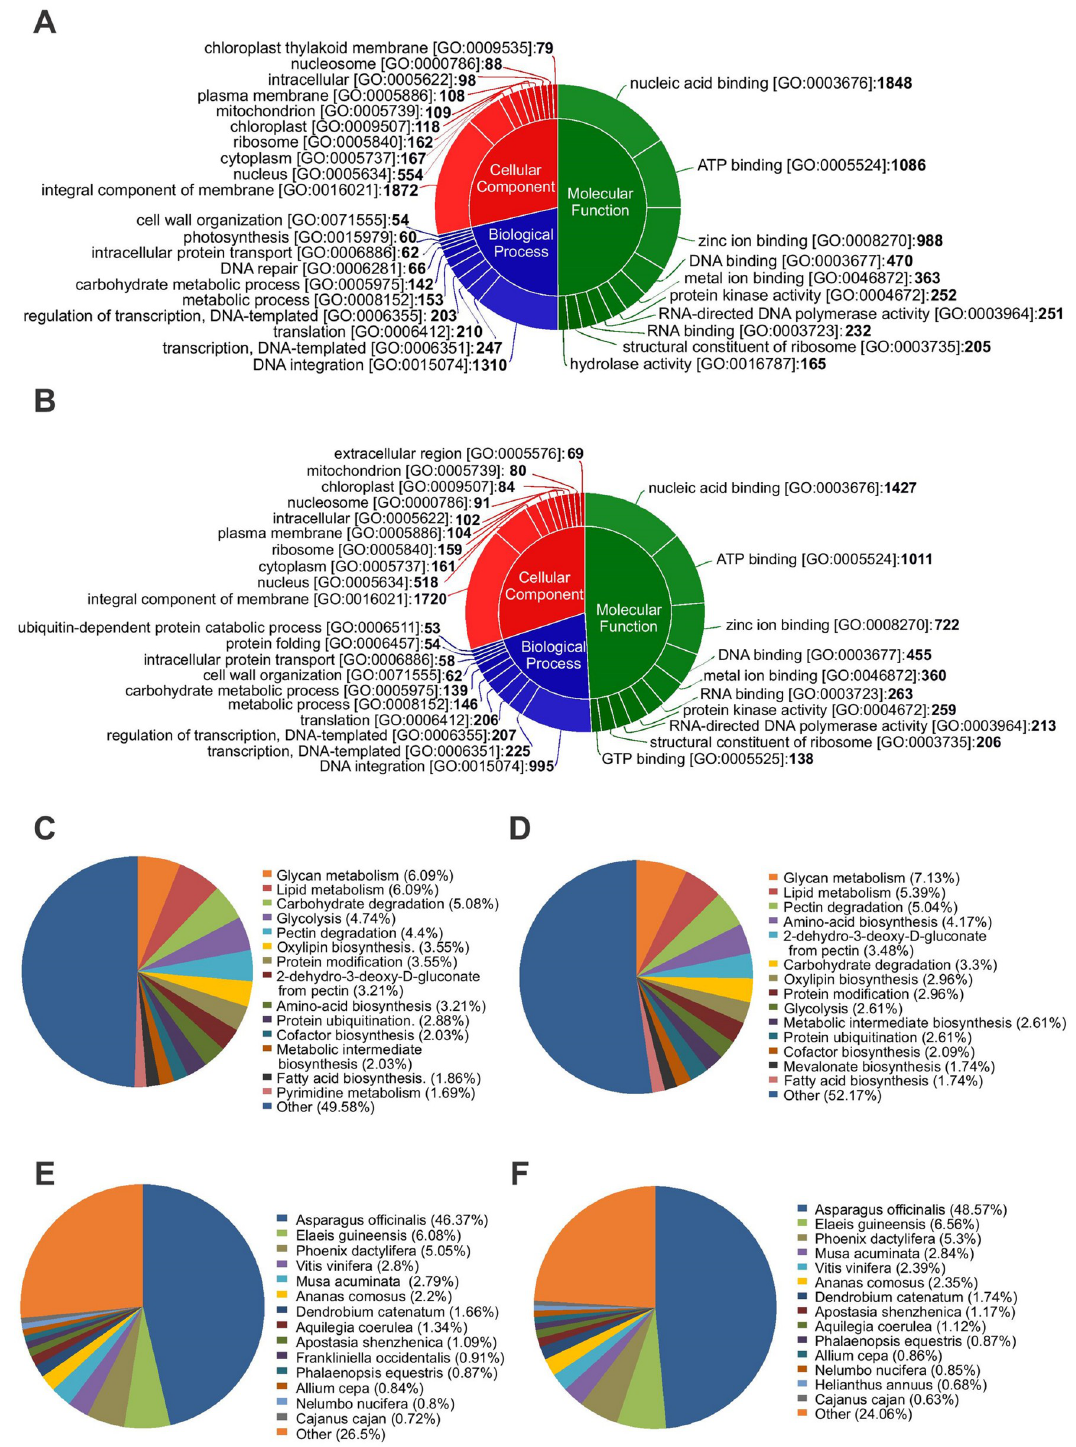
Fig 4. Functional annotation of transcripts expressed in drought sensitive (1627) and tolerant (1656) onion genotypes under drought stress. A, B: Gene ontology, C,D: KEGG pathway analyses, E,F: Species hit distribution.